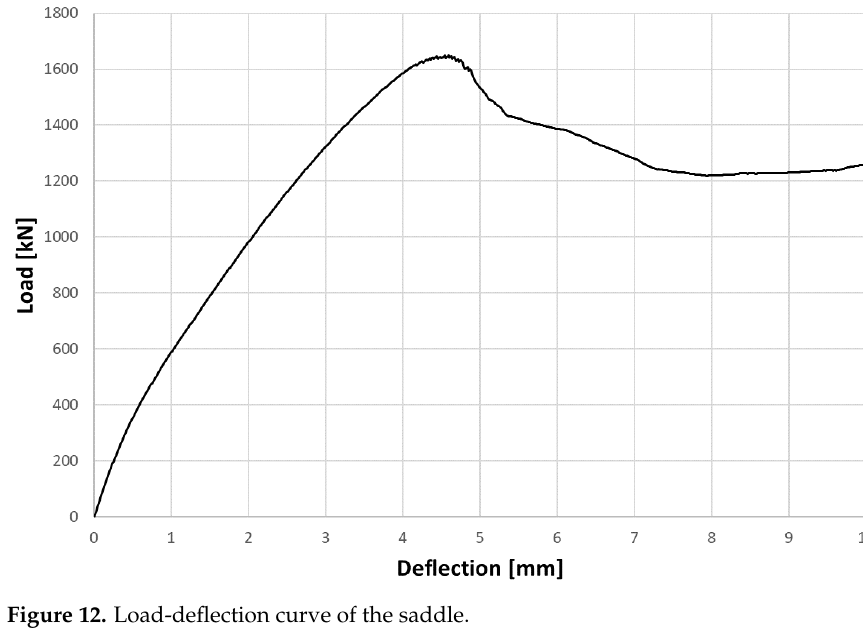
Figure 12. Load-deflection curve of the saddle.